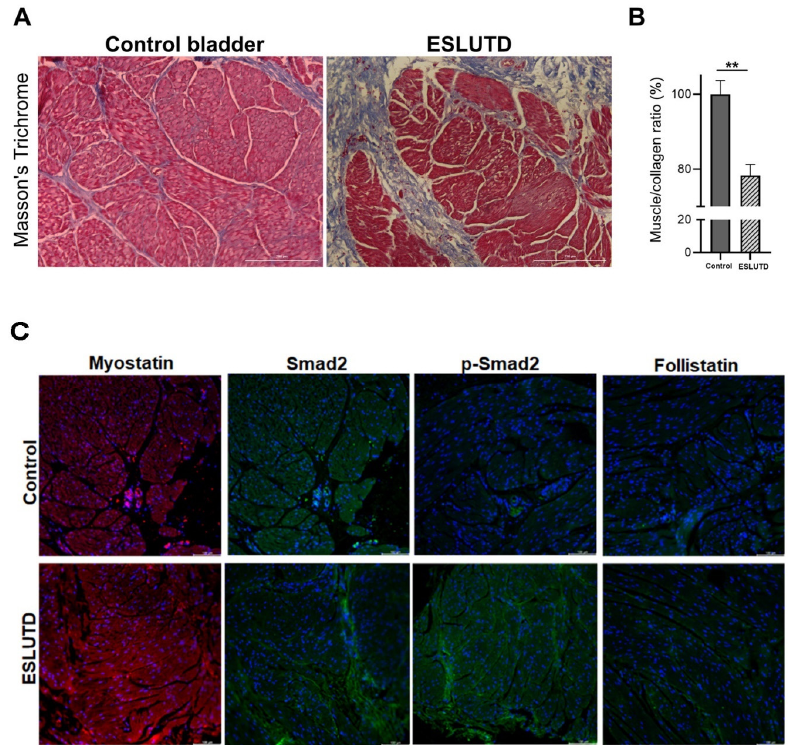
Figure 2. Differences in muscle-to-collagen ratio and Smad pathway proteins in control and ESLUTD bladder. ( A ) Masson’s trichrome staining in control and ESLUTD bladder detrusor muscle with smooth muscle tissue (red) and connective tissue (blue). ( B ) Quantification of muscle-to-collagen ratio in control (n = 4) and ESLUTD (n = 4) smooth muscle tissue, normalized to control taken as 100%. Muscle-to-collagen ratio was significantly lower in ESLUTD compared to control bladder. Statistics with unpaired t -test, ** p ≤ 0.01. ( C ) Antibody staining for myostatin (red) and its signaling pathway proteins Smad 2 (green), p-Smad 2 (green) and follistatin (green) with cell nuclei in blue. Scale bar, 100 μ m.